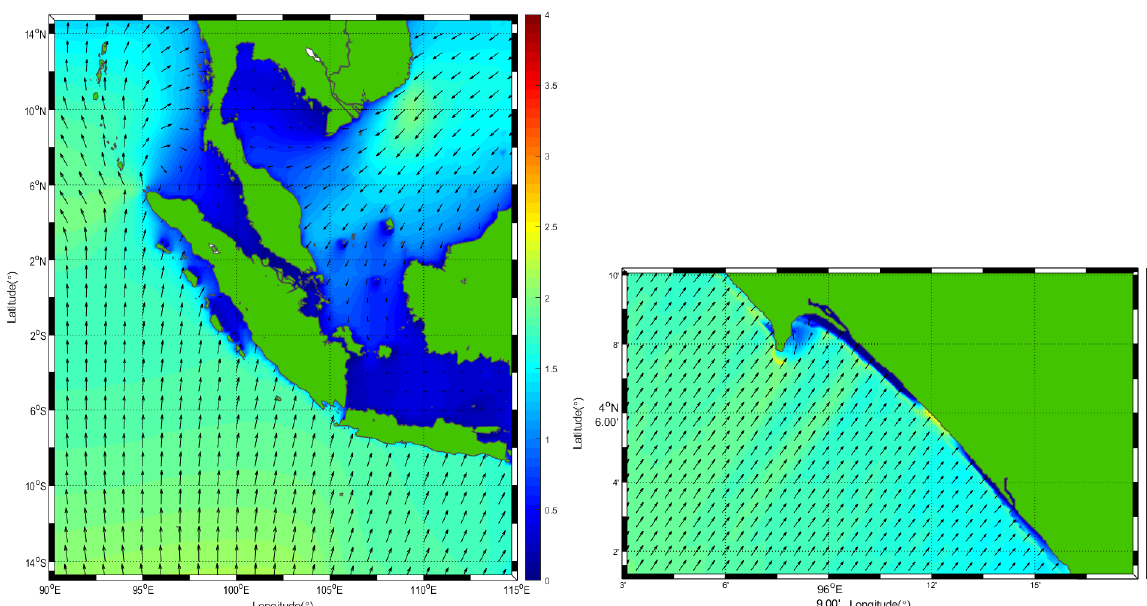
Figure 8. Snapshot of significant wave height on 1 March 2020, at 00:00 UTC, from wave simulation using SWAN model for domains II ( left plot ) and III ( right plot ) for Meulaboh area. Table 2. Numerical configuration for the SWAN model for the Meulaboh case.